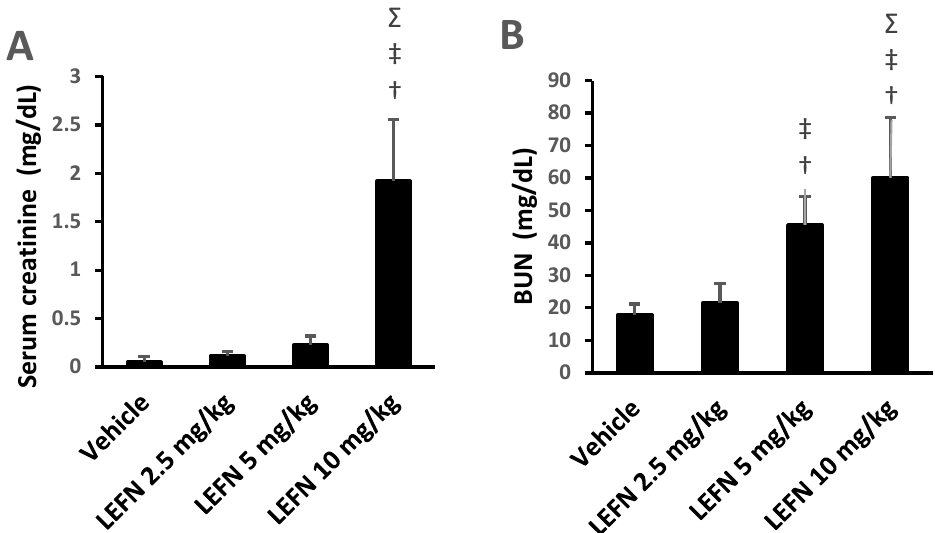
Figure 3. Effect of LEFN on kidney function parameters in adult mice. ( A ) Serum creatinine, ( B ) BUN. Data are mean ± SD, and analysis was performed by applying one-way ANOVA and Bonferroni’s test at p < 0.05. †: versus the vehicle group, ‡: versus the LEFN 2.5 mg/kg group, and Σ: versus the LEFN 5 mg/kg group. BUN: blood urea nitrogen.